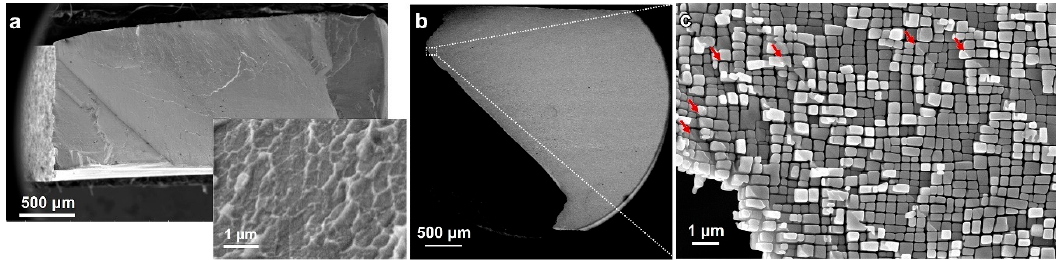
Figure 10. Fracture analysis after tensile testing at 650 °C. ( a ) Fracture surface of the sample, whose zoomed in image is shown in the inset. The loading direction is out of plane. ( b ) Side view of the fractured sample. ( c ) Magnified microstructure near the fracture surface, captured from the white dashed rectangle in ( b ). The loading direction is horizontal.